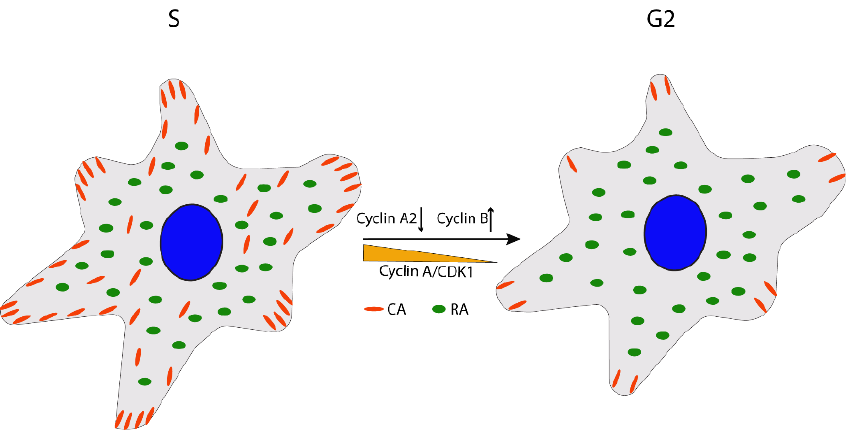
Figure 2. The schematic top view picture indicates that the number and size of CA area is shrinking in the G2 phase mainly due to the inactivation of cyclin A2/CDK1 in the G2 phase while RAs are maintained.